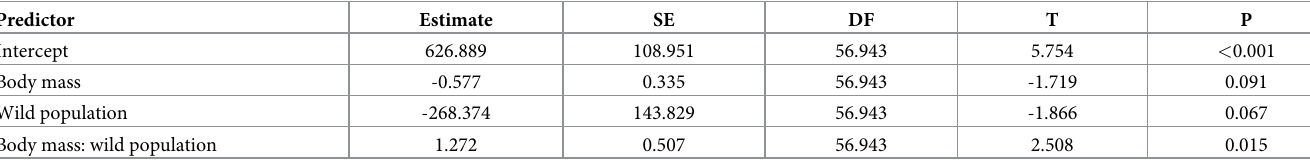
Table 4. Parameter estimates from the minimal adequate model for bioluminescent bacterial half-life following exposure to mallard plasma, used as a proxy of complement activity (n wild = 23, n farmed =